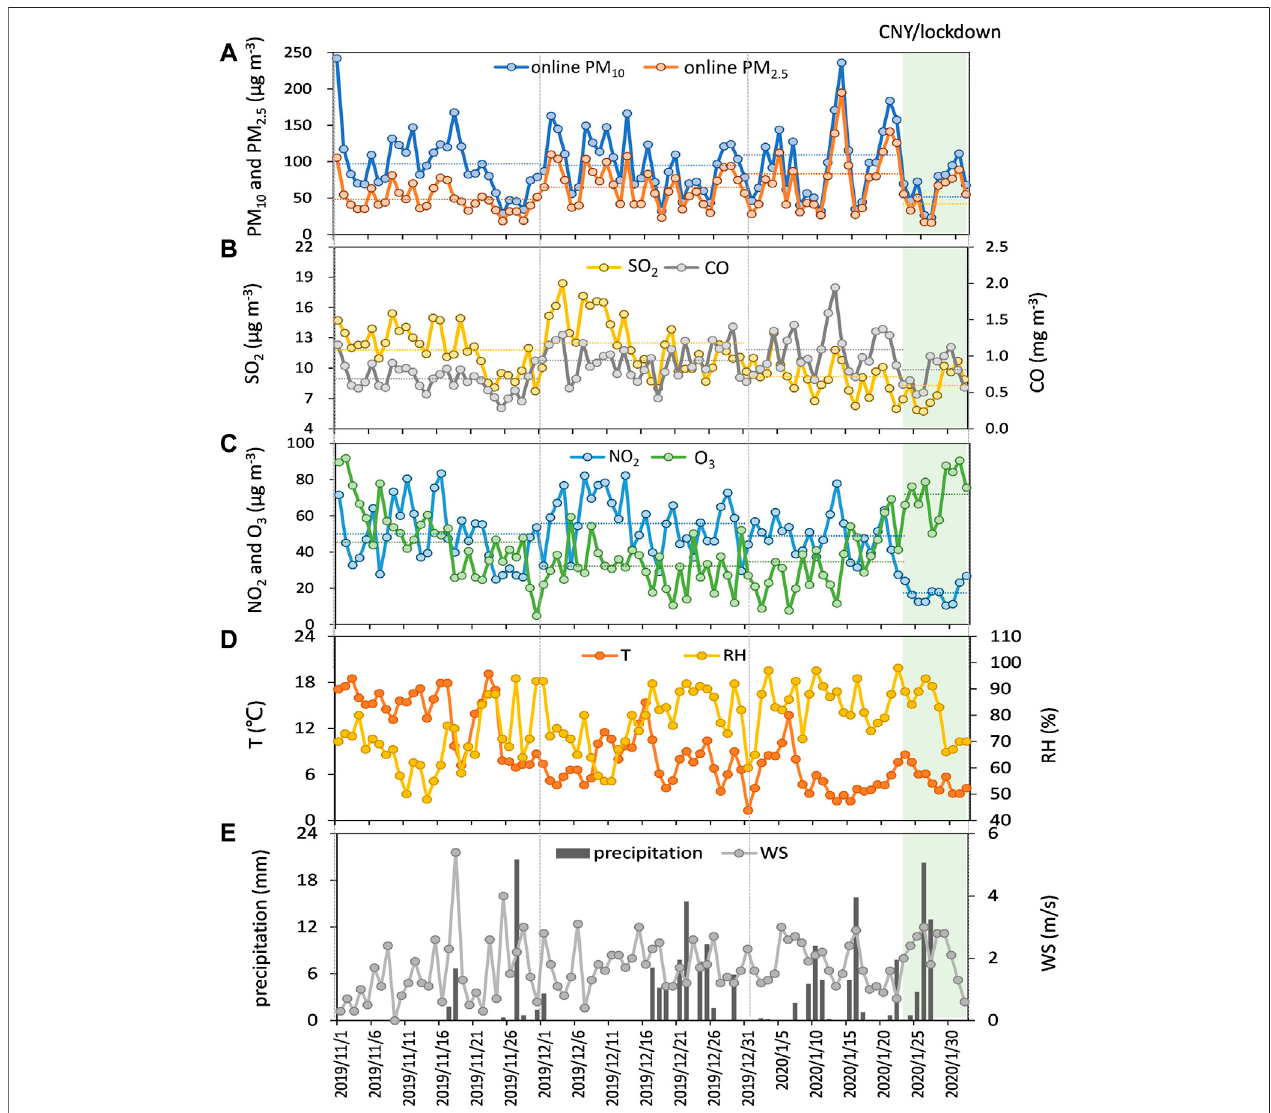
FIGURE 2 | Time series of (A) PM 10 and PM 2.5 concentrations, (B) SO 2 and CO concentrations, (C) NO 2 and O 3 concentrations, (D) temperature and relative humidity, and (E) precipitation and wind speed from 1 November 2019 to 1 February 2020 (The dotted lines represent the mean concentrations for each